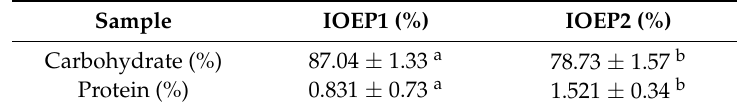
Table 1. Major chemical composition of polysaccharides.